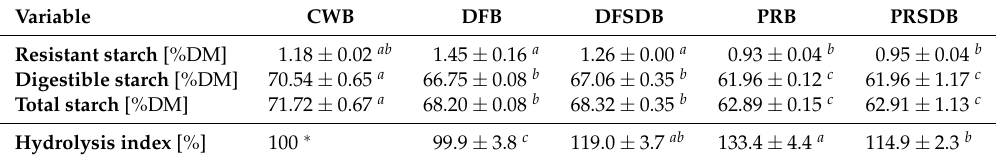
Table 7. Values for resistant, digestible and total starch reported in %DM and hydrolysis indices (HIs) determined by in vitro starch digestion and monitoring of released reducing sugars over a time of 240 min for CWB, DFB, DFSDB, PRB and